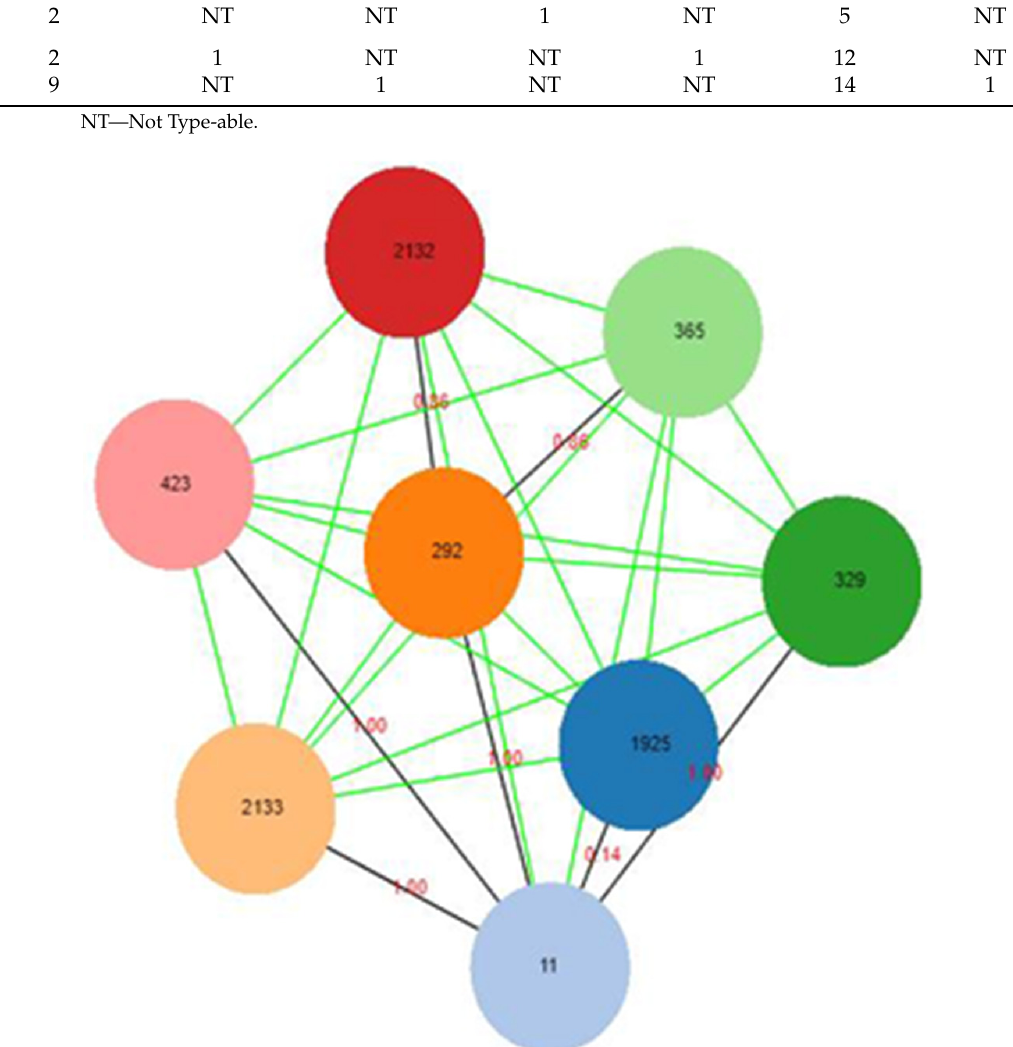
Figure 1. MLST Clonal Complex defined by goeBURST for Salmonella Enteritidis isolates. Each coloured node represents a clone in relation to their absolute distance, with ST11 being more closely related to ST1925.